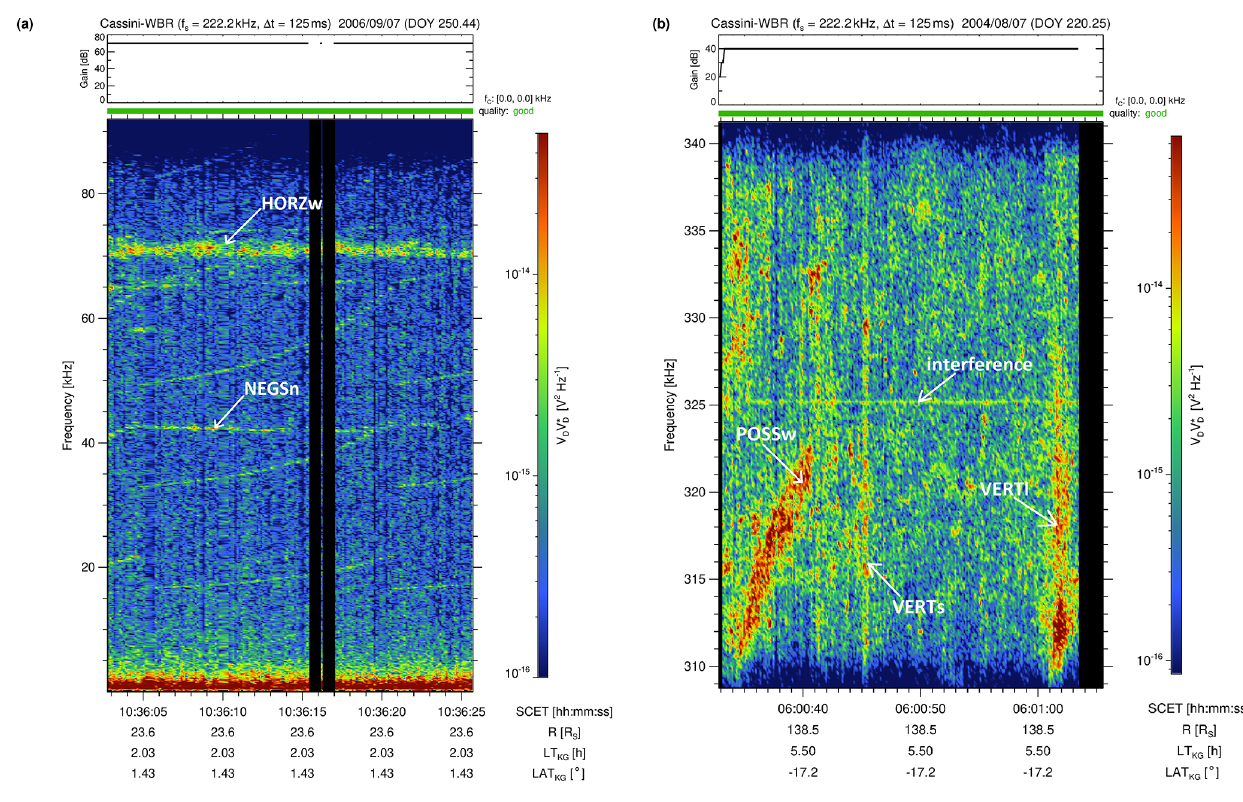
Figure 2. Fine structures of the classes HORZ (a) and VERT (b) show horizontal and vertical linear features of Saturn kilometric radiation,